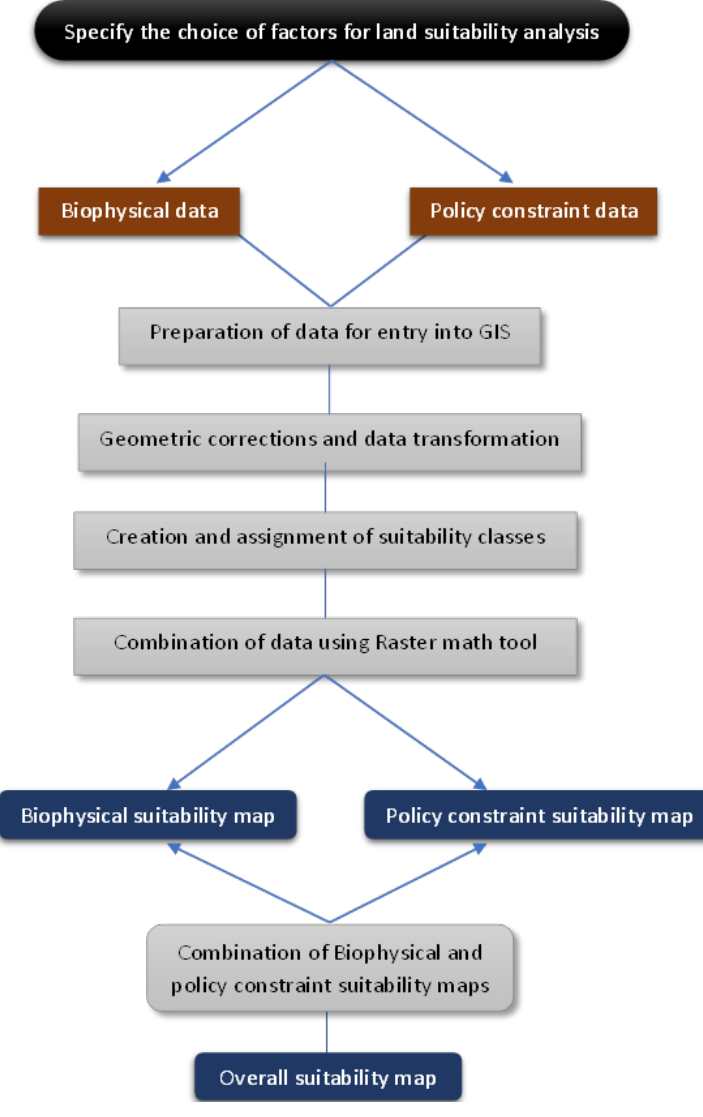
Figure 1. Methodology flow chart for land suitability analysis.